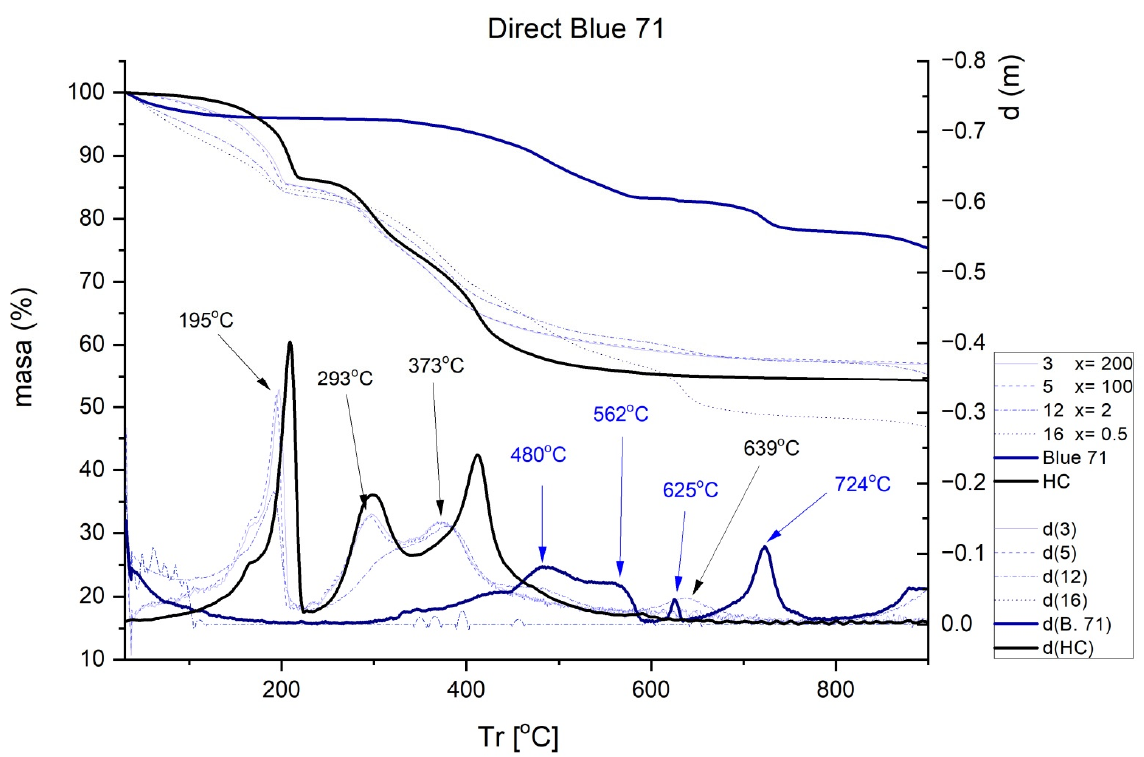
Figure 8. TGA and DTGA of Direct Blue 71 free and adsorbed.